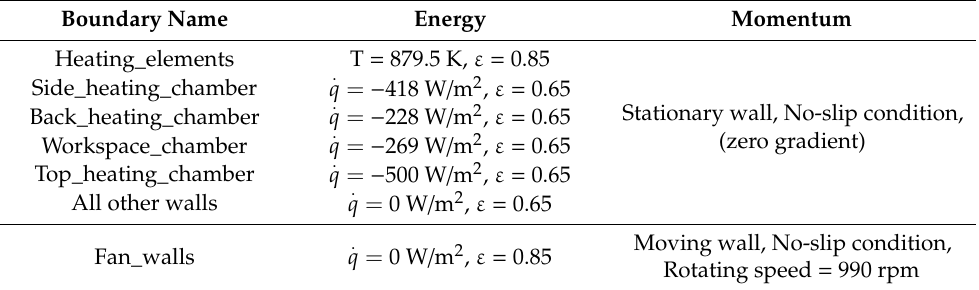
Table 1. Wall boundary conditions for baseline